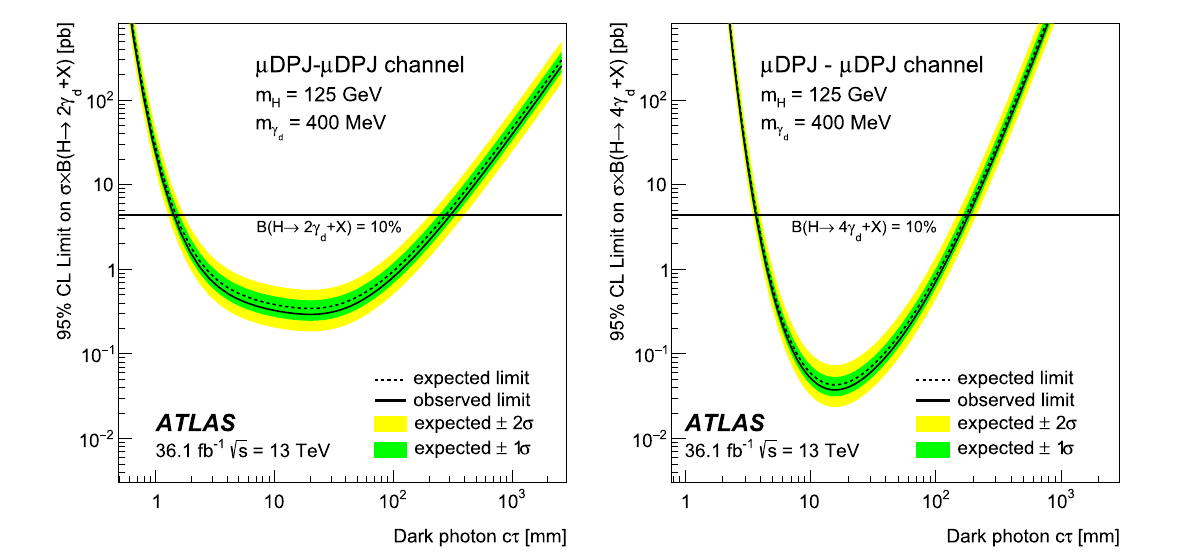
Fig. 5 Upper limits at 95% CL on the cross section times branching fraction for the processes H → 2 γ d + X (left) and H → 4 γ d + X (right) in the μ DPJ– μ DPJ final states for m H = 125 GeV. The hori-